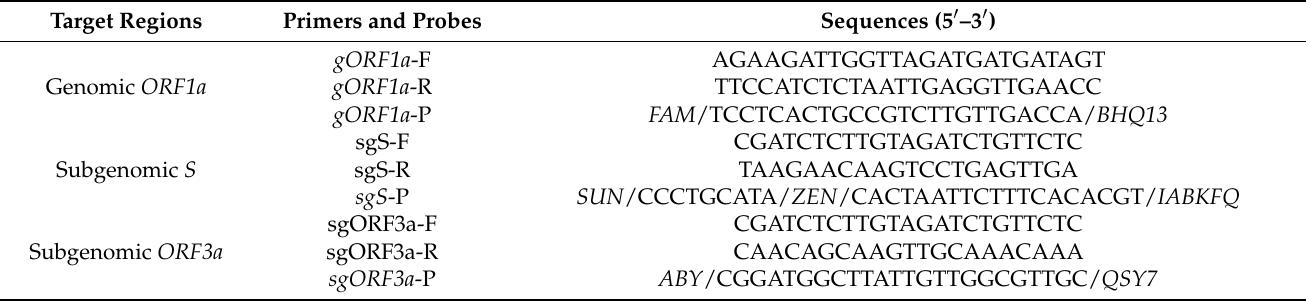
Table 1. Primer and probe sets for detection of SARS-CoV-2 genomic and subgenomic